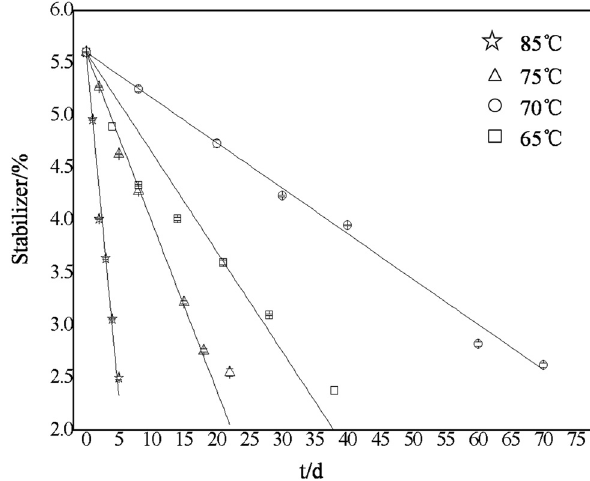
Figure 2: Stabilizer depletion of GaTo propellants with error bars at 85, 75, 70, and 65°C.